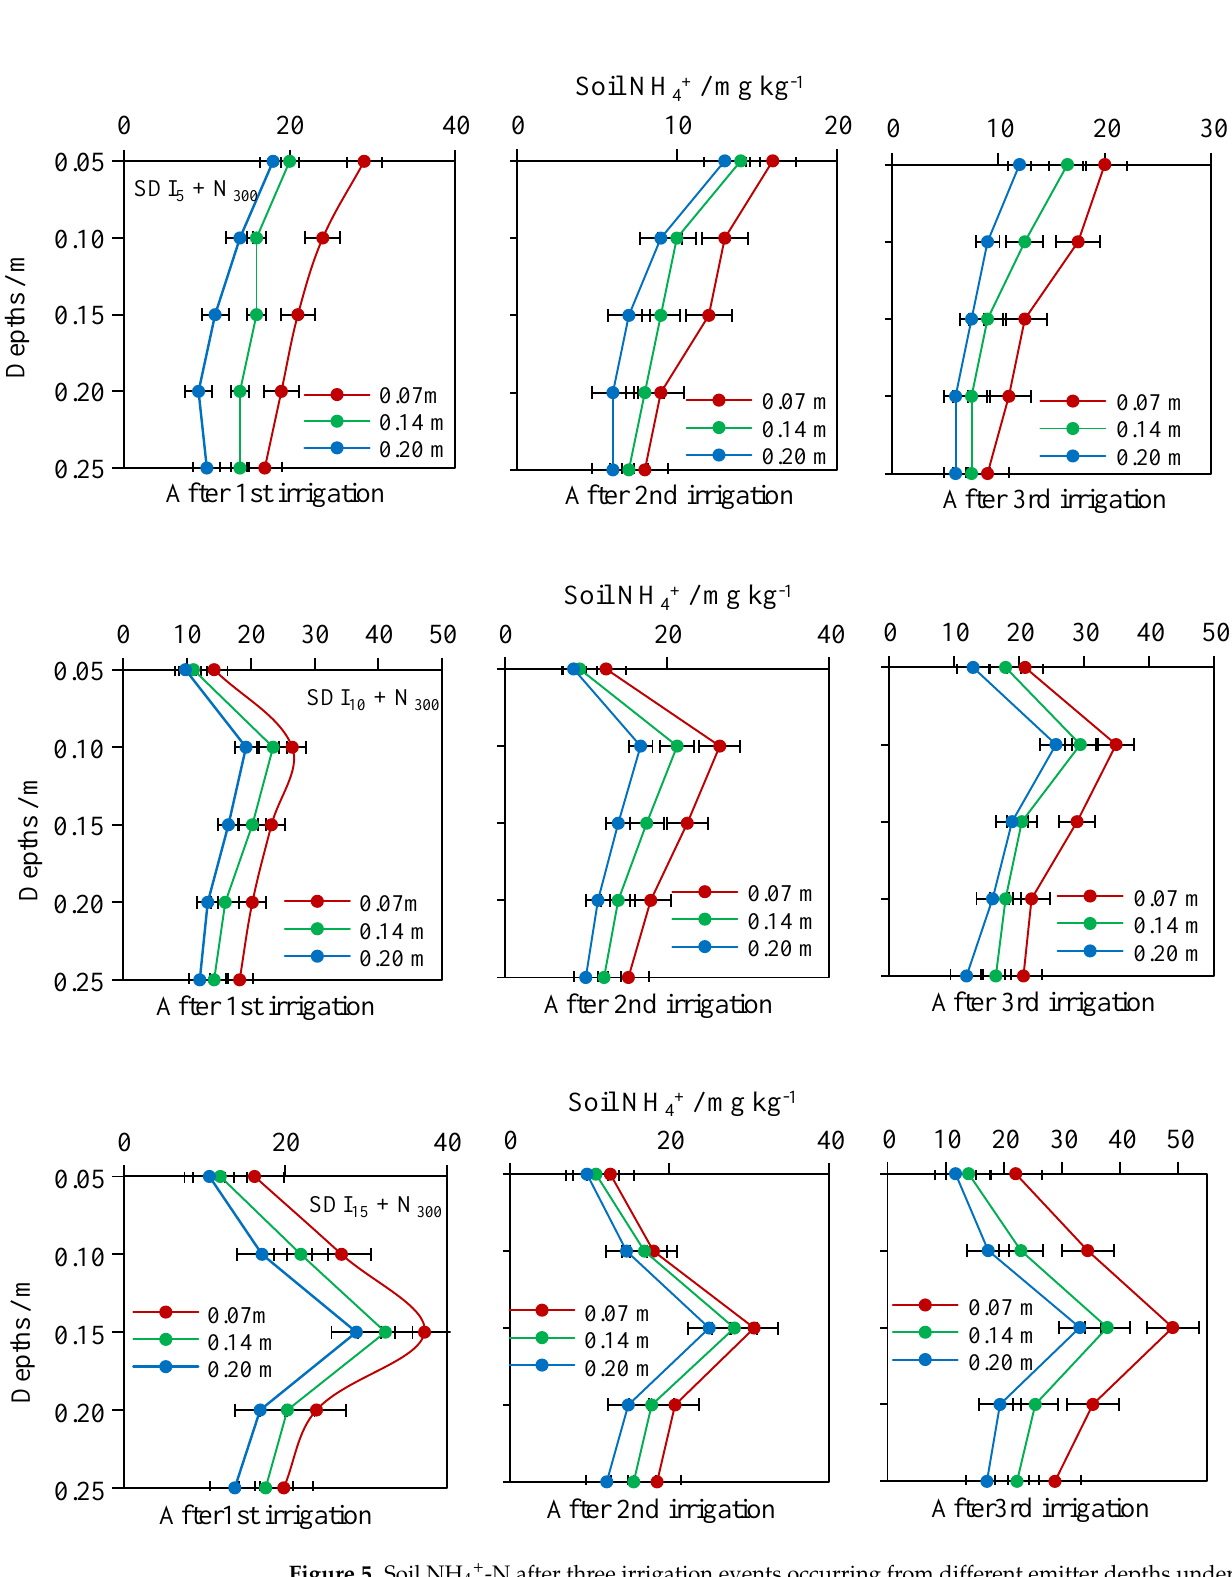
Figure 5. Soil NH 4+ -N after three irrigation events occurring from different emitter depths under the 300 kg N ha −1 fertilization rate. Error bars represent standard error.